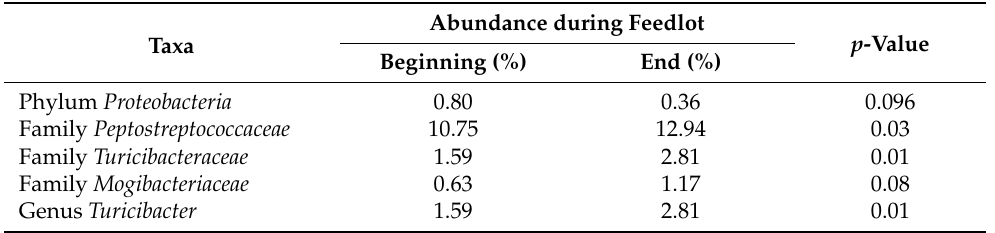
Table 3. Summary of all bacterial taxa found to be significantly changed (or with tendency to change) in the more efficient (Low RFI) steers from beginning to end of the feedlot period. Taxa